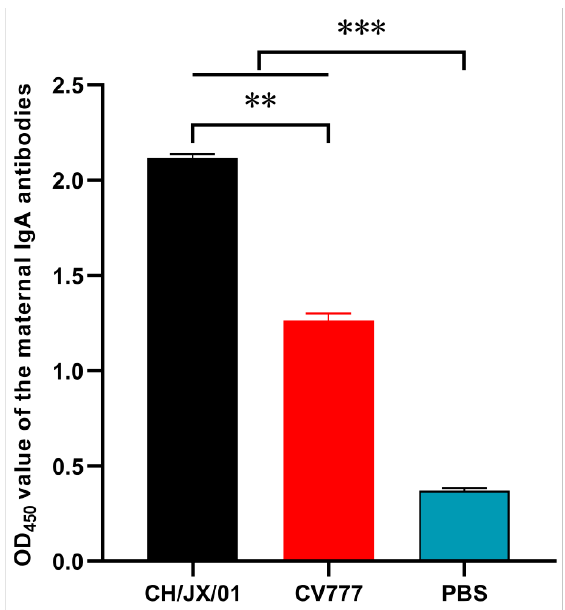
Figure 6. Group mean anti-PEDV sIgA response in maternal milk. Data presented as mean group ELISA sample-to-positive (S/P) ratios ± SEM. The significance level was set to ** indicates 0.001 < p ≤ 0.01, and *** indicates p ≤ 0.001.